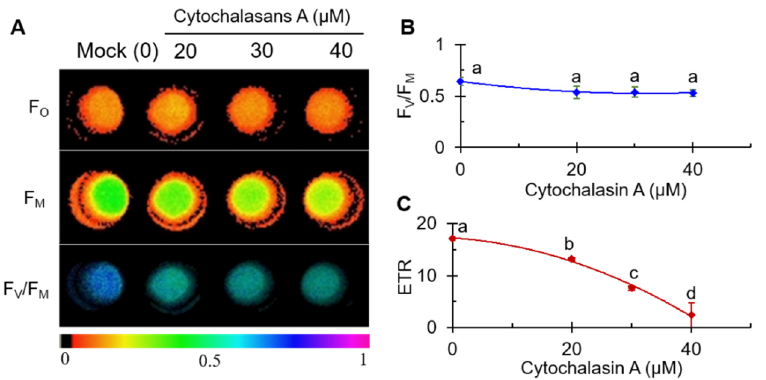
Figure 2. Effects of cytochalasin A on color fluorescence imaging of F O , F M and F V /F M ( A ), the value of the maximum quantum yield of PSII (F V /F M ) ( B ), and electron transport rate (ETR) ( C ) of C. reinhardtii cells. Fluorescence images were indicated by color code in the order of black (0) through red, orange, yellow, green, blue, violet to purple (1). The number codes above images are marked from 0 to 1, showing the changes. Each value is the average ± SE of three independent experiments with around 15 repetitions. The different lowercase letters (a,b,c,d) indicate to be statistical significance at 0.05 level.